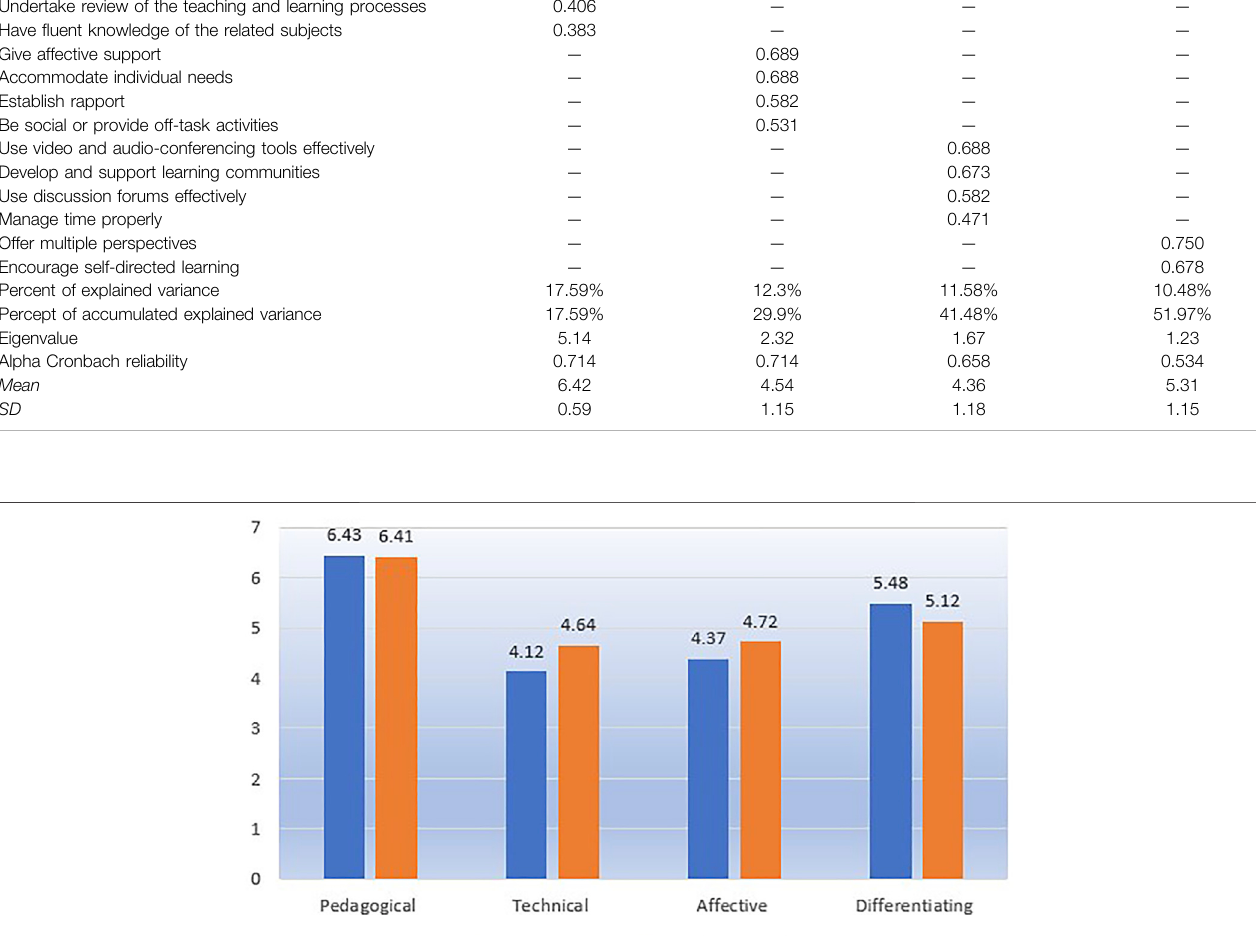
Frontiers in Education |